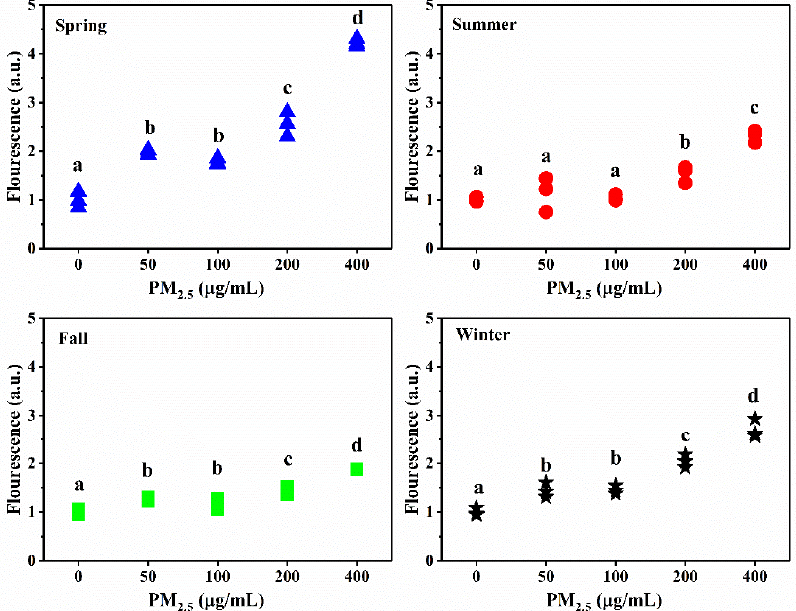
Figure 6. Relative ROS production in the A549 cells exposed to different concentrations of PM 2.5 Different letters (a, b, c, d) indicate significant differences among the five PM 2.5 treatments ( p < 0.05). Each dot is one replicate ( n = 3).